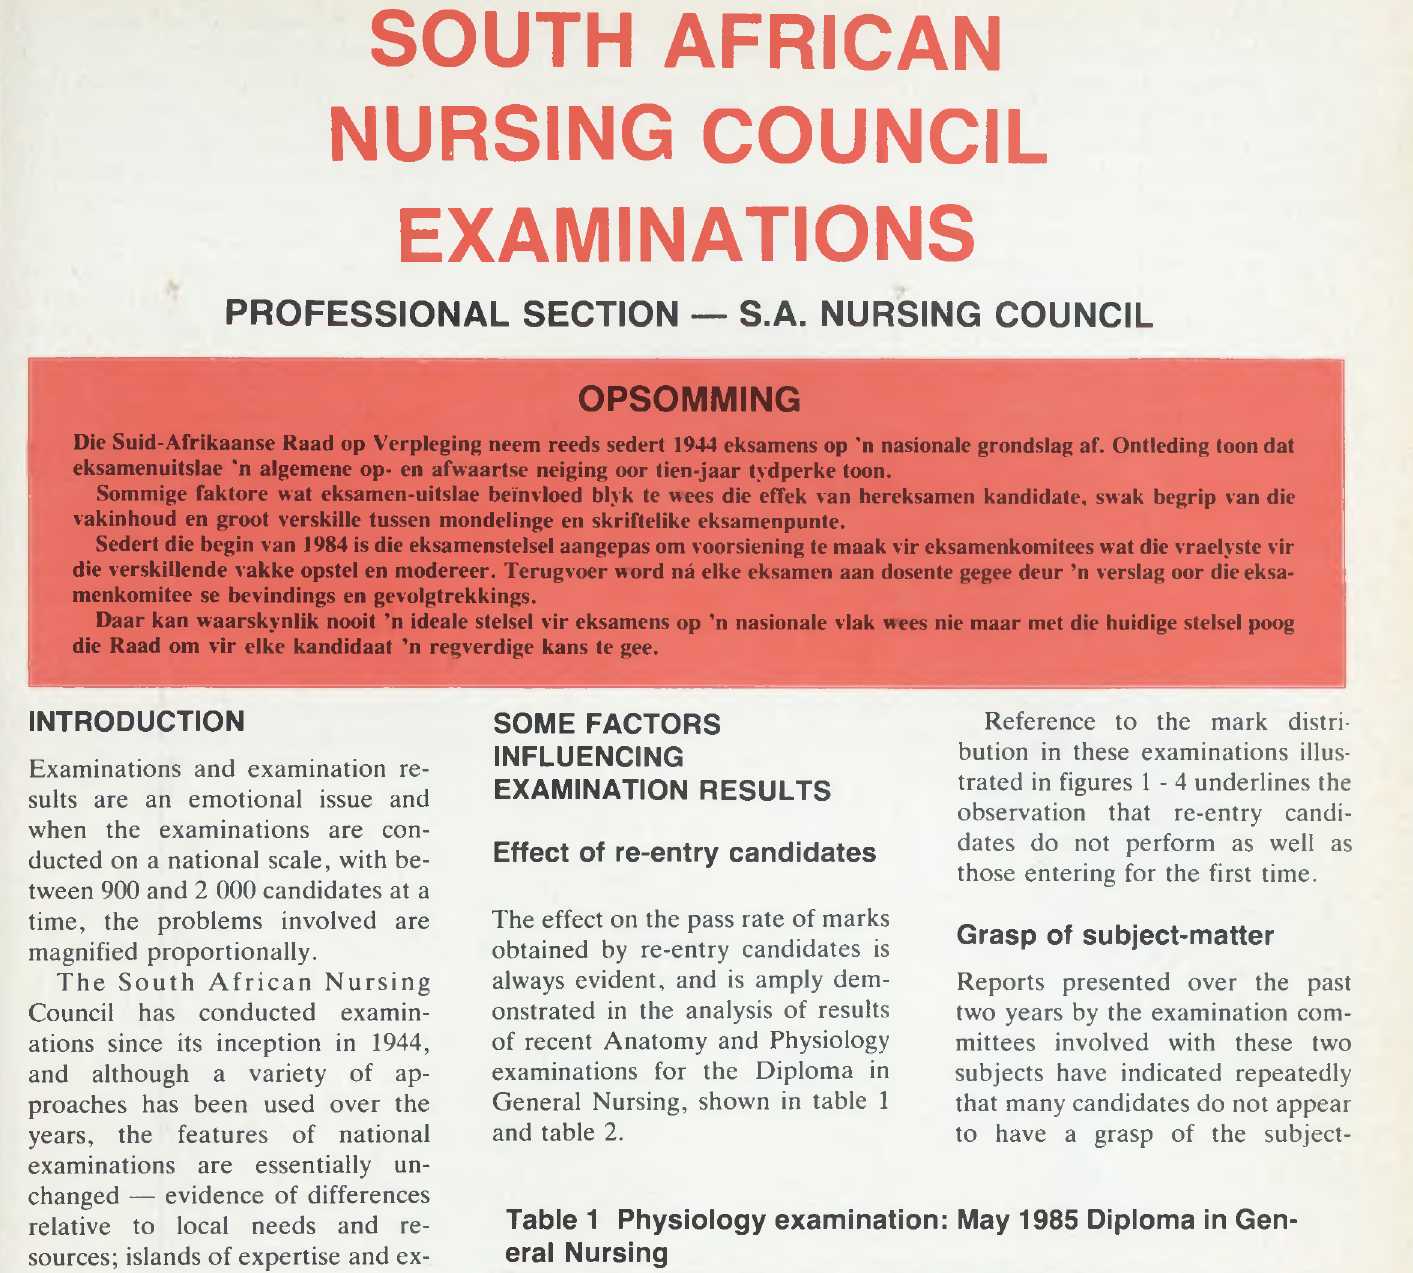
Table 2 Anatomy examination: June 1985 Diploma in